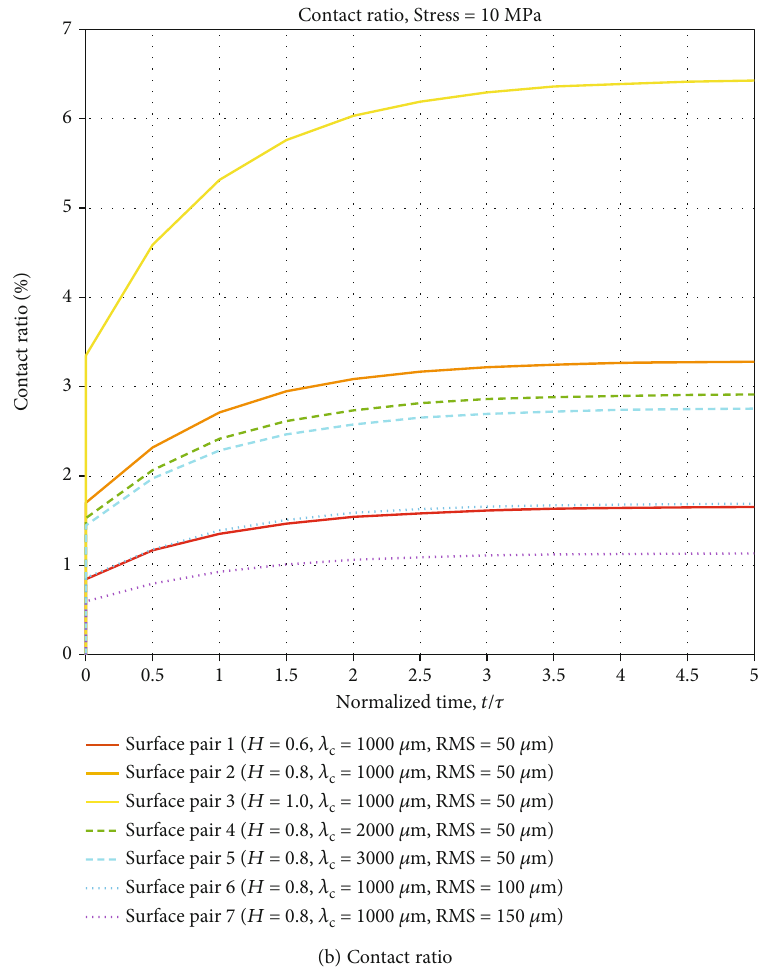
Figure 18: Creep deformation of the seven surface pairs (shown in Table 3). The time t is normalized by τ . (a) Mean aperture changing with time for the seven surface pairs; (b) contact ratio changing with time for the seven surface pairs.